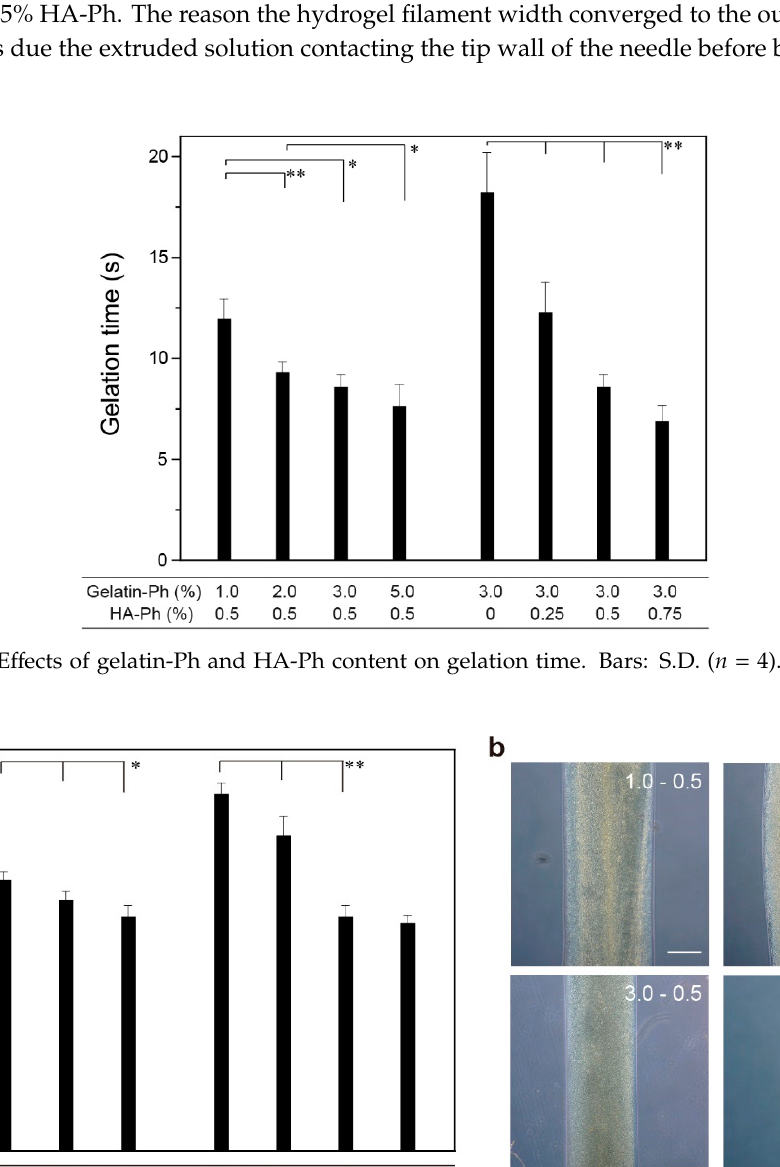
Figure 4. Effects of gelatin-Ph and HA-Ph content on the width of hydrogel filaments extruded on a stage. ( a ) Values normalized by an outer diameter of an extrusion needle (400 µ m). The linear velocity of the solution at the tip of the needle and the movement speed of the stage were set to be the same. Bars: S.D. ( n = 8). * p < 0.05, ** p < 0.01. ( b ) Microphotographs of hydrogel filaments at typical conditions. Bars: 200 µ